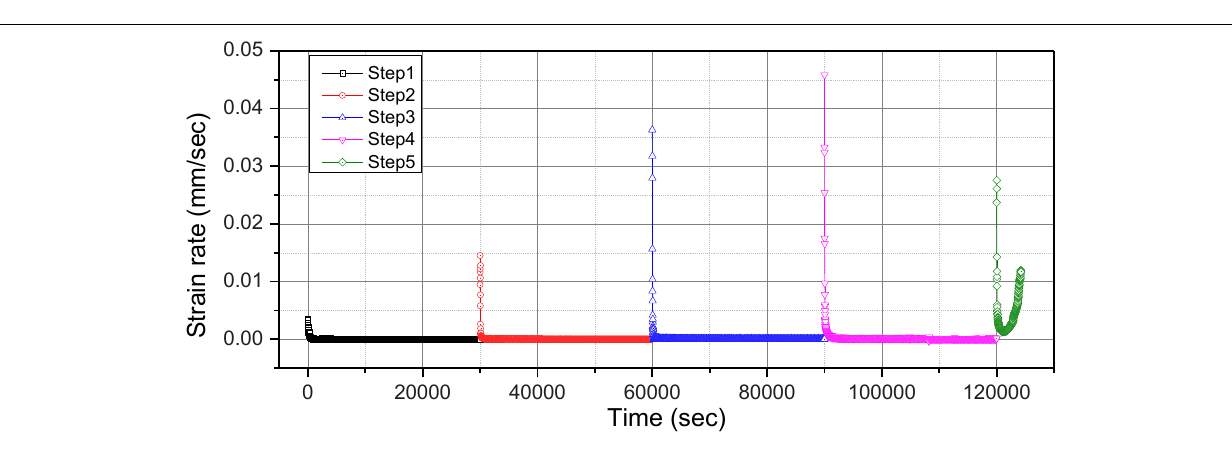
FIGURE 9 | Creep deformation tests curves for different confining pressure with time plotted in logarithm scale.